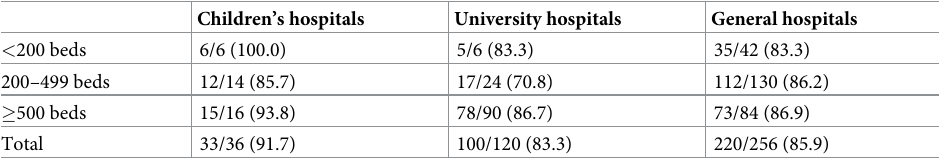
Table 3. Response rates according to size and type of